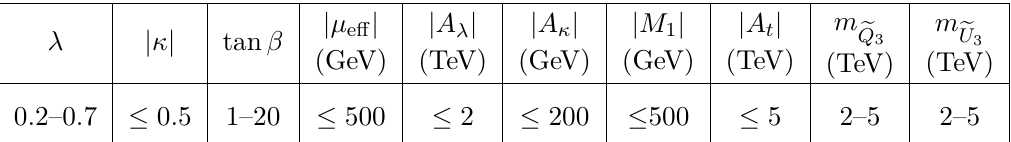
= m = 3 . 5 TeV, ˜ L, e E e D 3